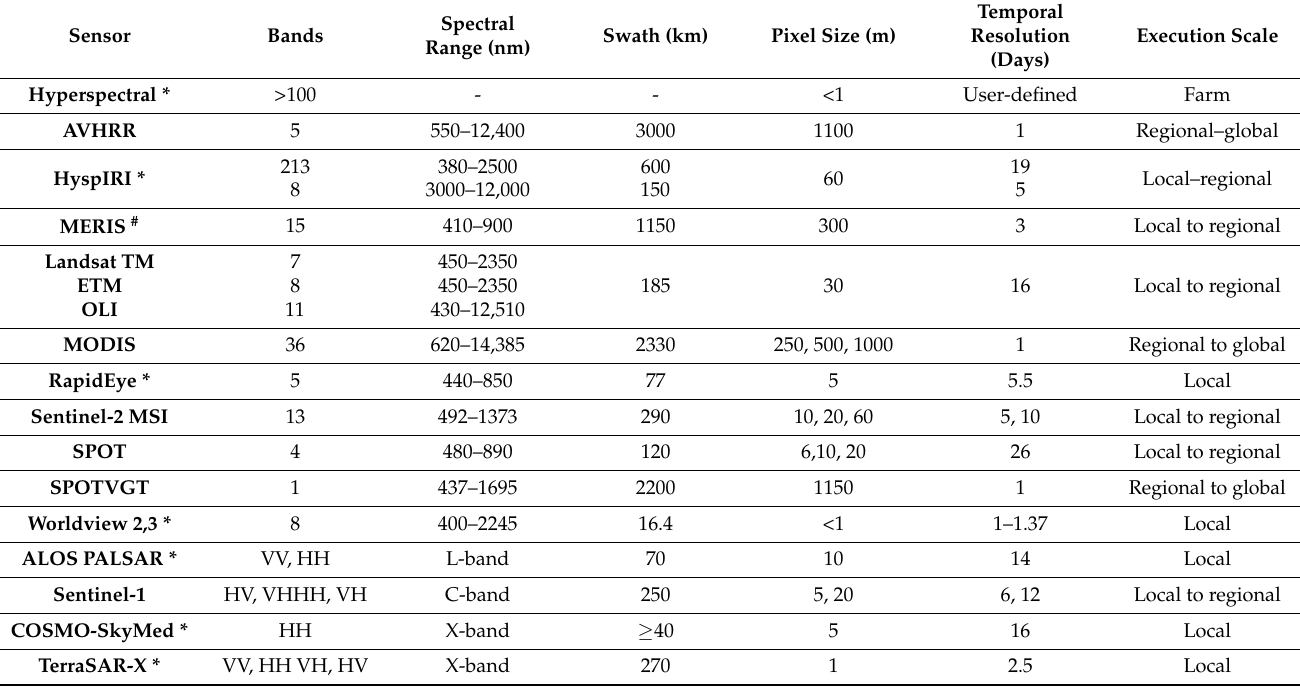
Table 2. Characteristics of the most frequently used